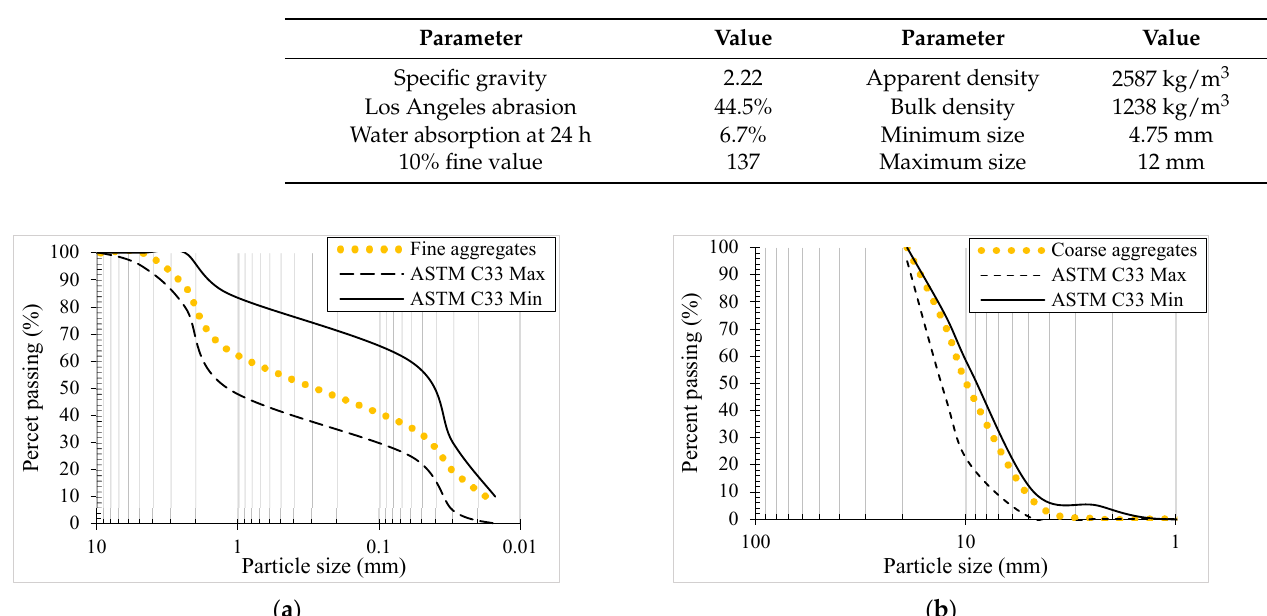
Table 1. Properties of RCA.